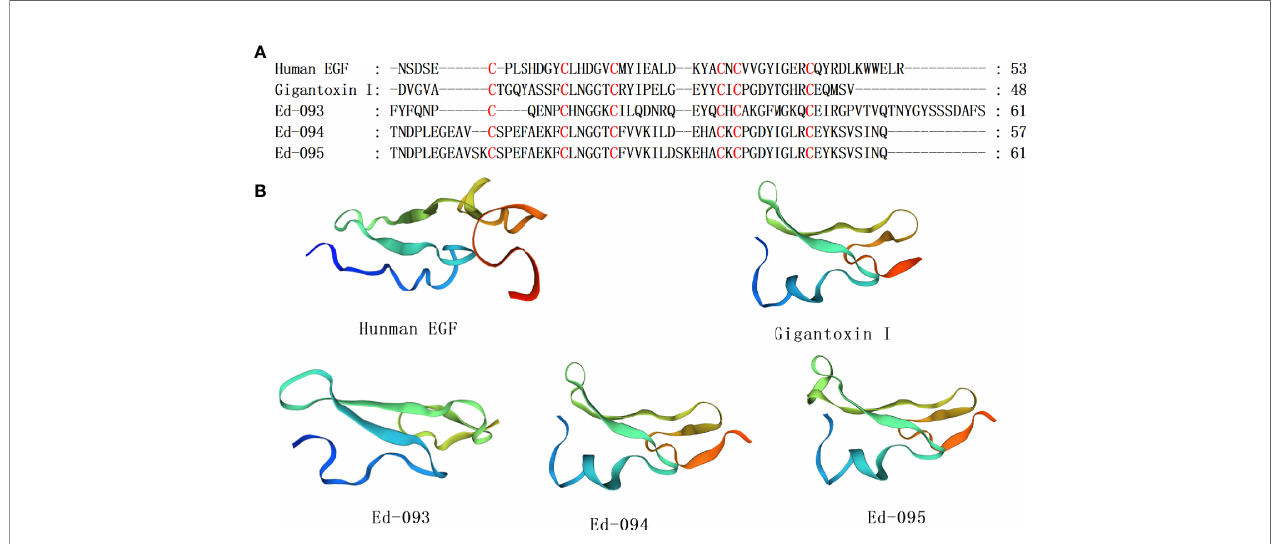
FIGURE 5 | Representative sea anemone mature peptide sequences with EGF. (A) Alignment of sea anemone mature peptides with EGF. Cysteines are highlighted in red; (B) Homology modeling prediction of the representative sea anemone mature peptide Gigantoxin I, Ed-093, Ed-094 and Ed-095 with Human